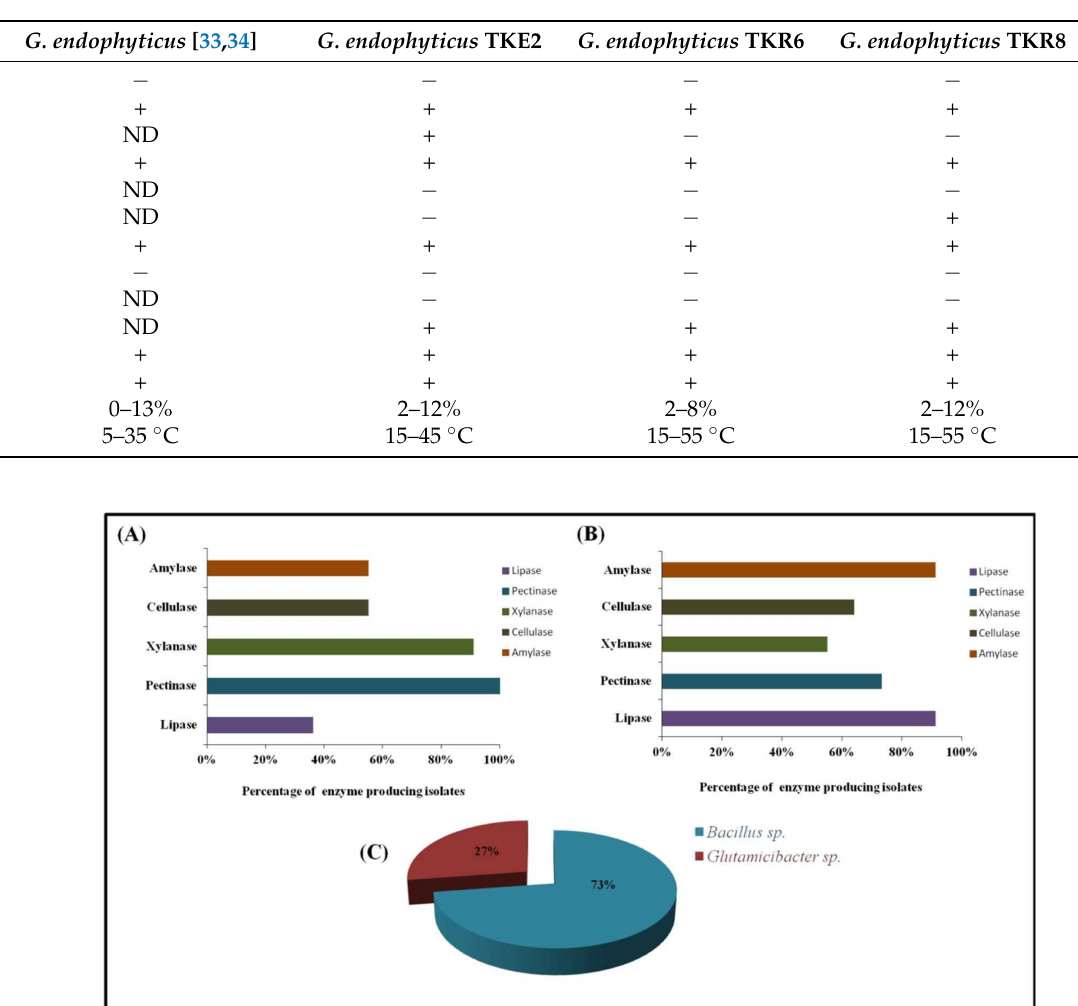
Table 3. Physiological and biochemical characteristics of G. endophyticus TKE2, TKR6, and TKR8.